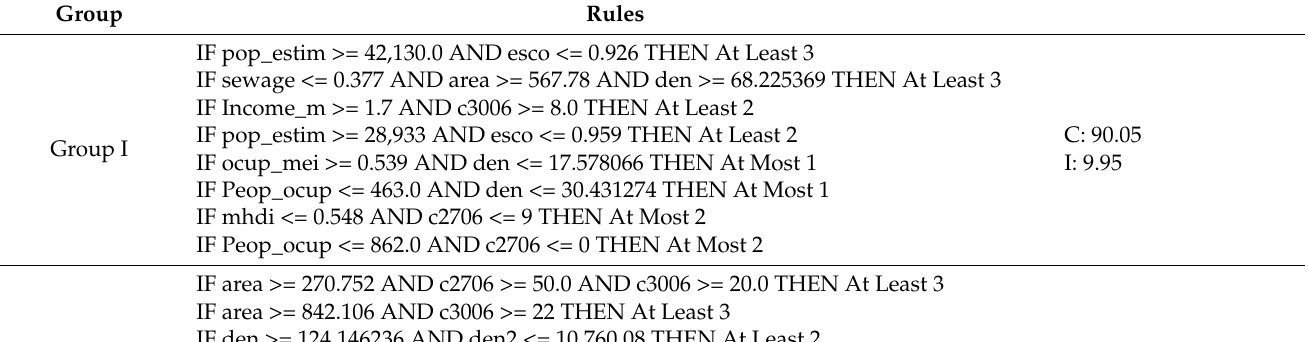
Table 8. Sample of decision rules obtained from